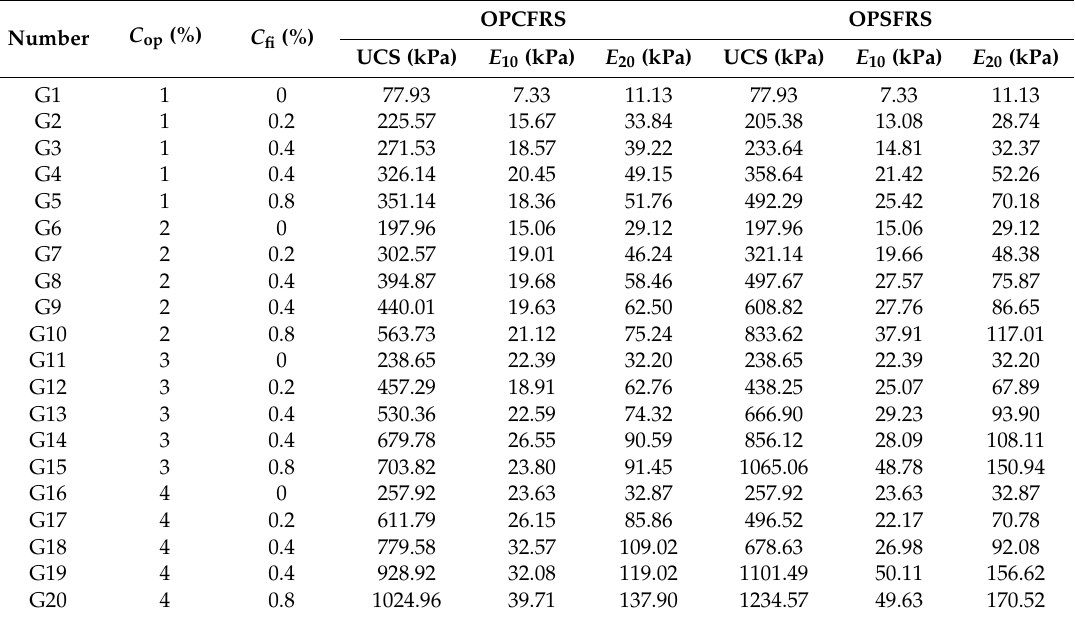
Table 3. The test results of OPSS, OPCFRS, and